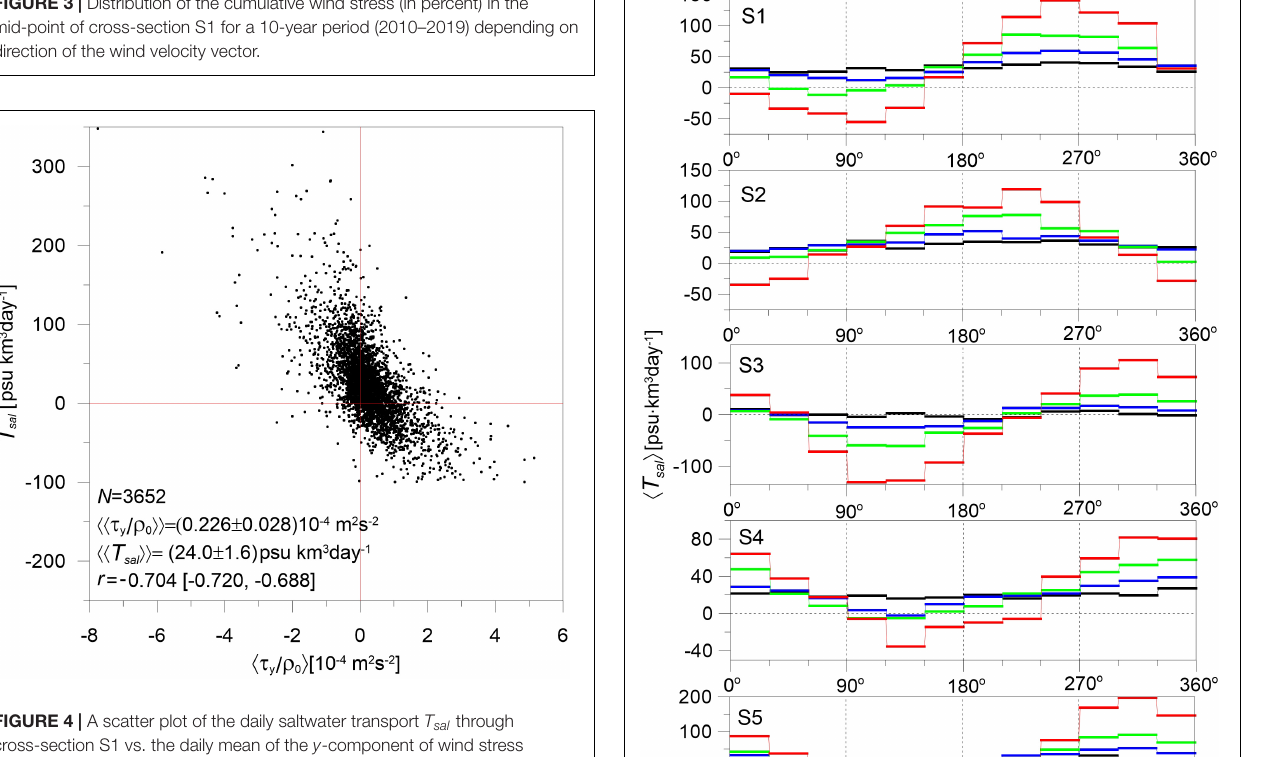
The correlation coefficient for the 10-year time series of T sal and (cid:104) τ y / ρ 0 (cid:105) is r = 0.704. Note that the 10-year mean values of (cid:104) τ y / ρ 0 (cid:105) and T S are (cid:104)(cid:104) τ y / ρ 0 (cid:105)(cid:105) = (0.226 ± 0.028) · 10 − 4 m 2 s − 2 (which confirms the prevalence of southerly winds in accordance to Figure 3 ) and (cid:104)(cid:104) T sal (cid:105)(cid:105) = 24.5 ± 1.6 psu · km 3 day − 1 (which